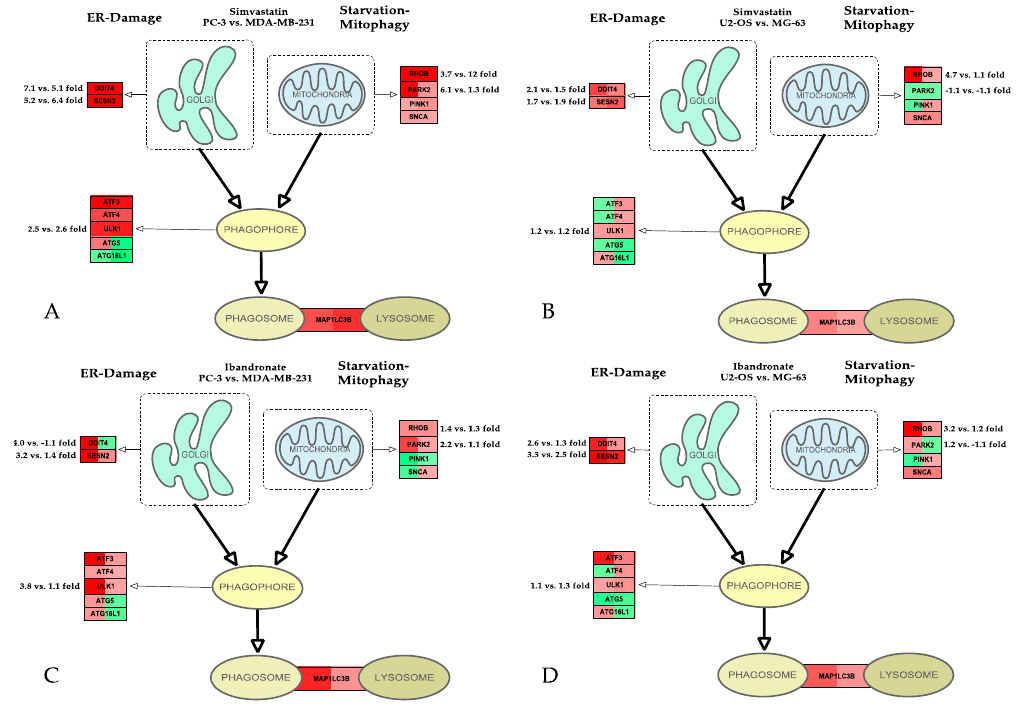
Figure 3. Results of transcriptomic analyses of autophagy-associated genes from PC-3 ( A ); MDA-MB-231 ( B ); U-2 OS ( C ) and MG-63 ( D ) cells using the Pathvisio tool. Upregulated genes are red, downregulated genes are green. ER, endoplasmic reticulum.